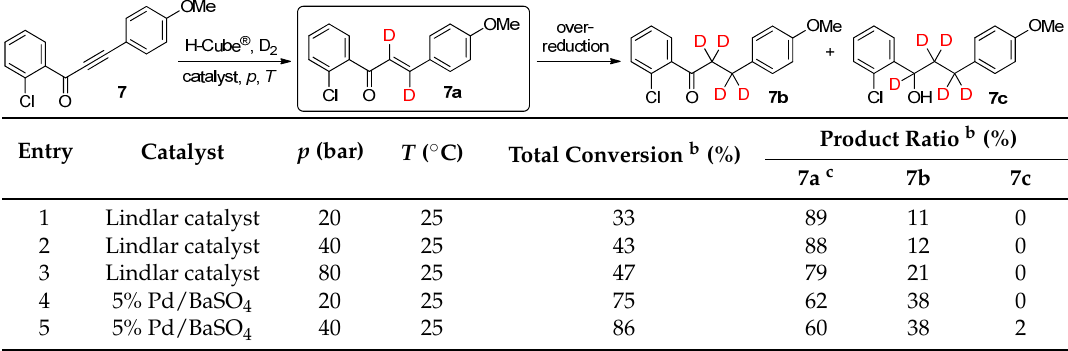
Table 3. Continuous-flow deuteration of 7 a .